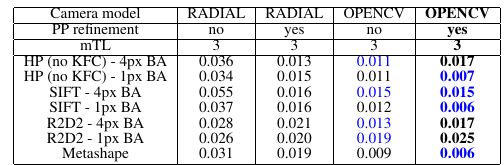
Table 3. RMSEs [m] for different camera setups of the Paestum Wall Normal dataset.